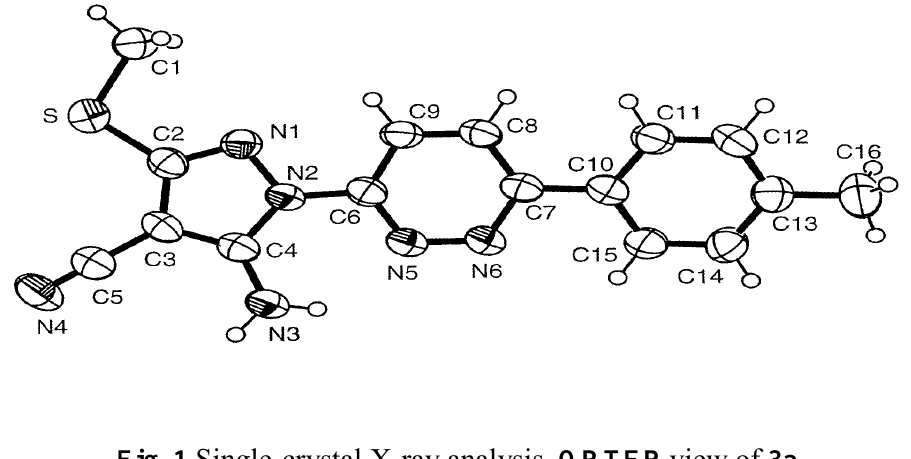
Fig. 1 Single-crystal X-ray analysis. ORTEP view of 3a showing the atom numbering